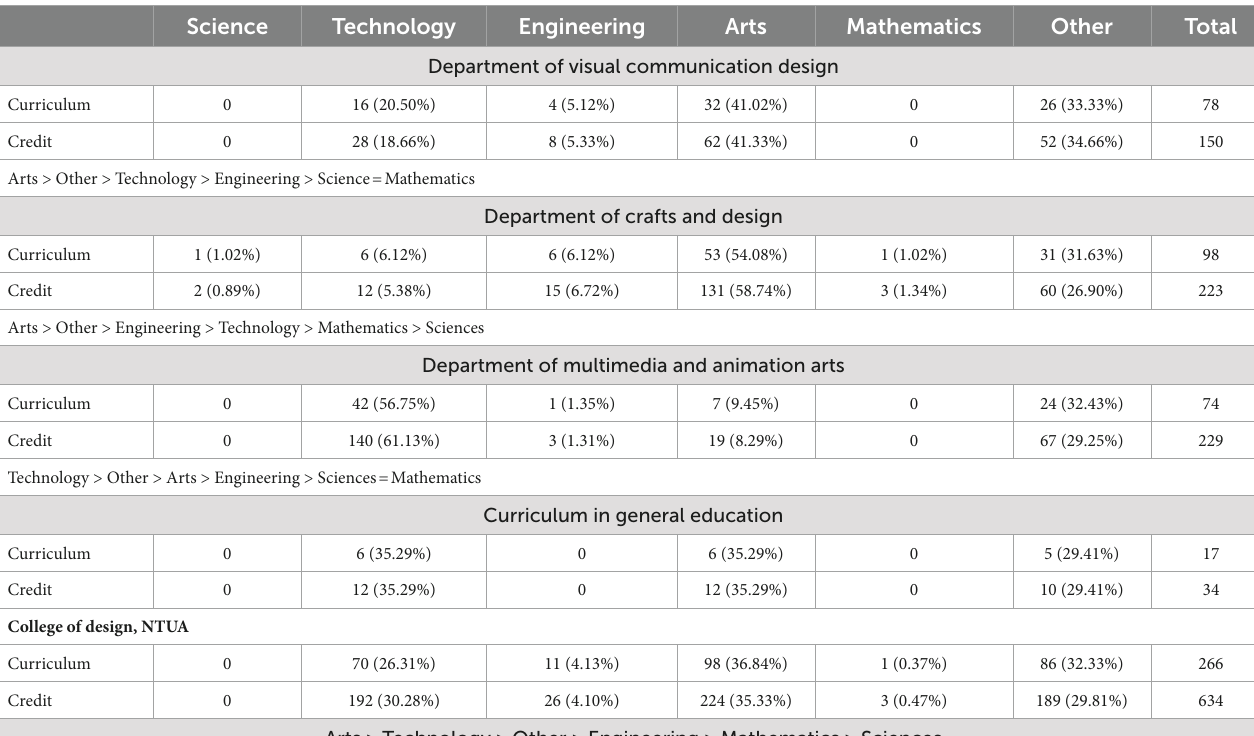
TABLE 10 The curriculum of the college of design, NTUA.